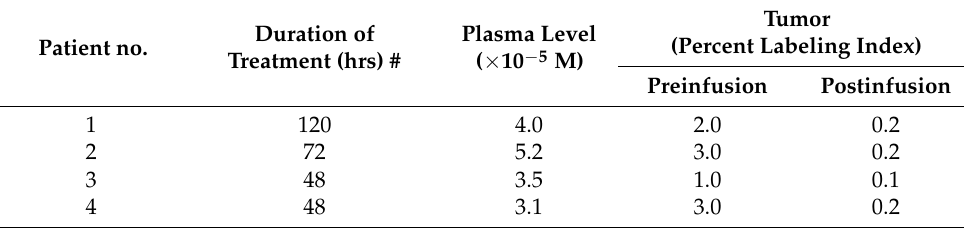
Table 2. Effect of dopamine on tumors in patients with malignant melanoma. Modified from [56].